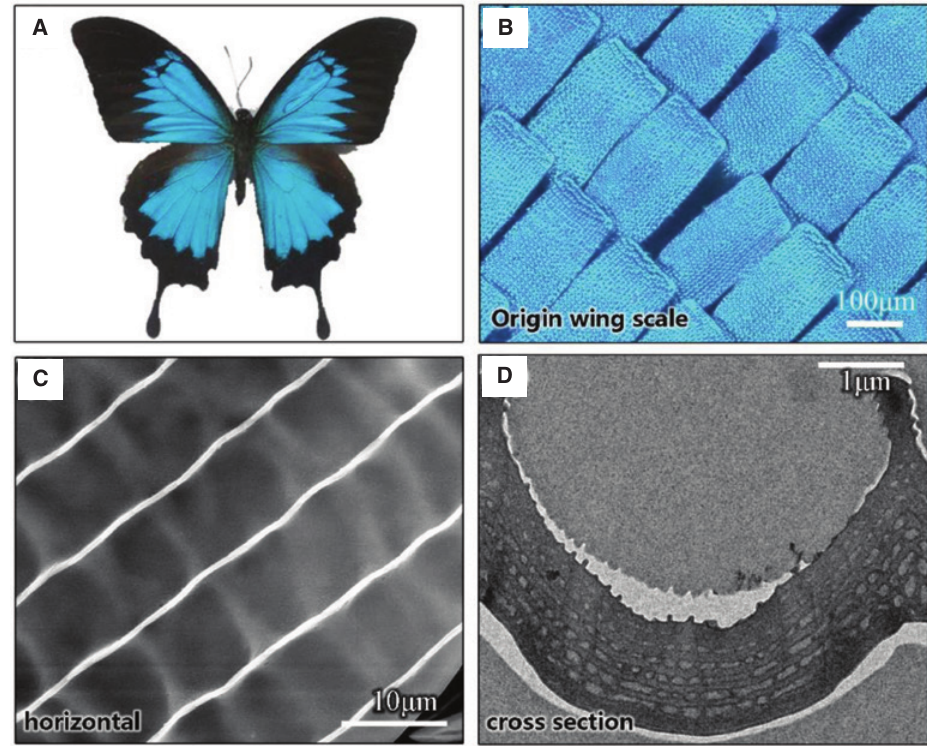
Figure 1: Sparkling color and periodic concave multilayer of the Papilio ulysses wing with PC structure. (A) Digital photo of natural Papilio ulysses butterfly. (B) Optical microscopy image of Papilio ulysses wing scale. (C) SEM micrograph of Papilio ulysses from a horizontal view. (D) TEM micrograph of Papilio ulysses from a cross-section